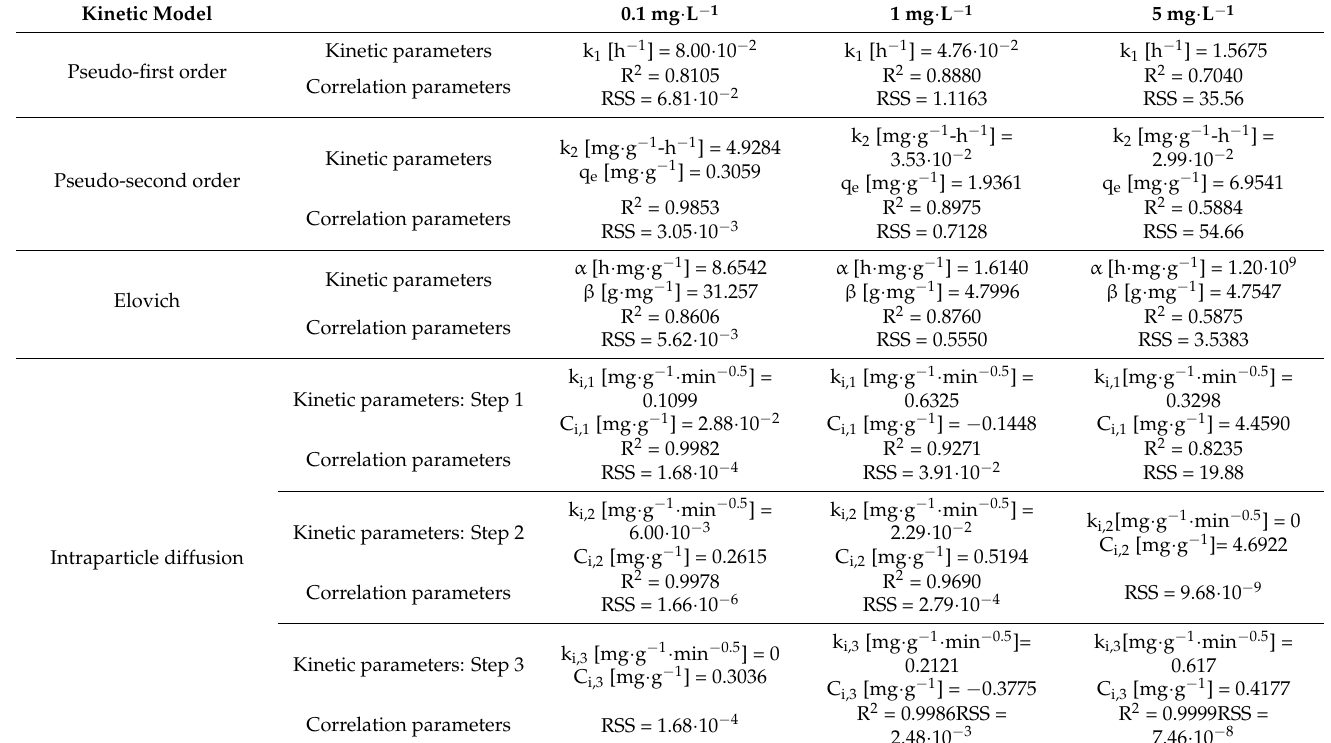
Table A4. The results of the kinetic equation adjustment to the adsorption experimental data of the initial hexavalent chromium concentrations from 0.1 to 50 mg · L − 1